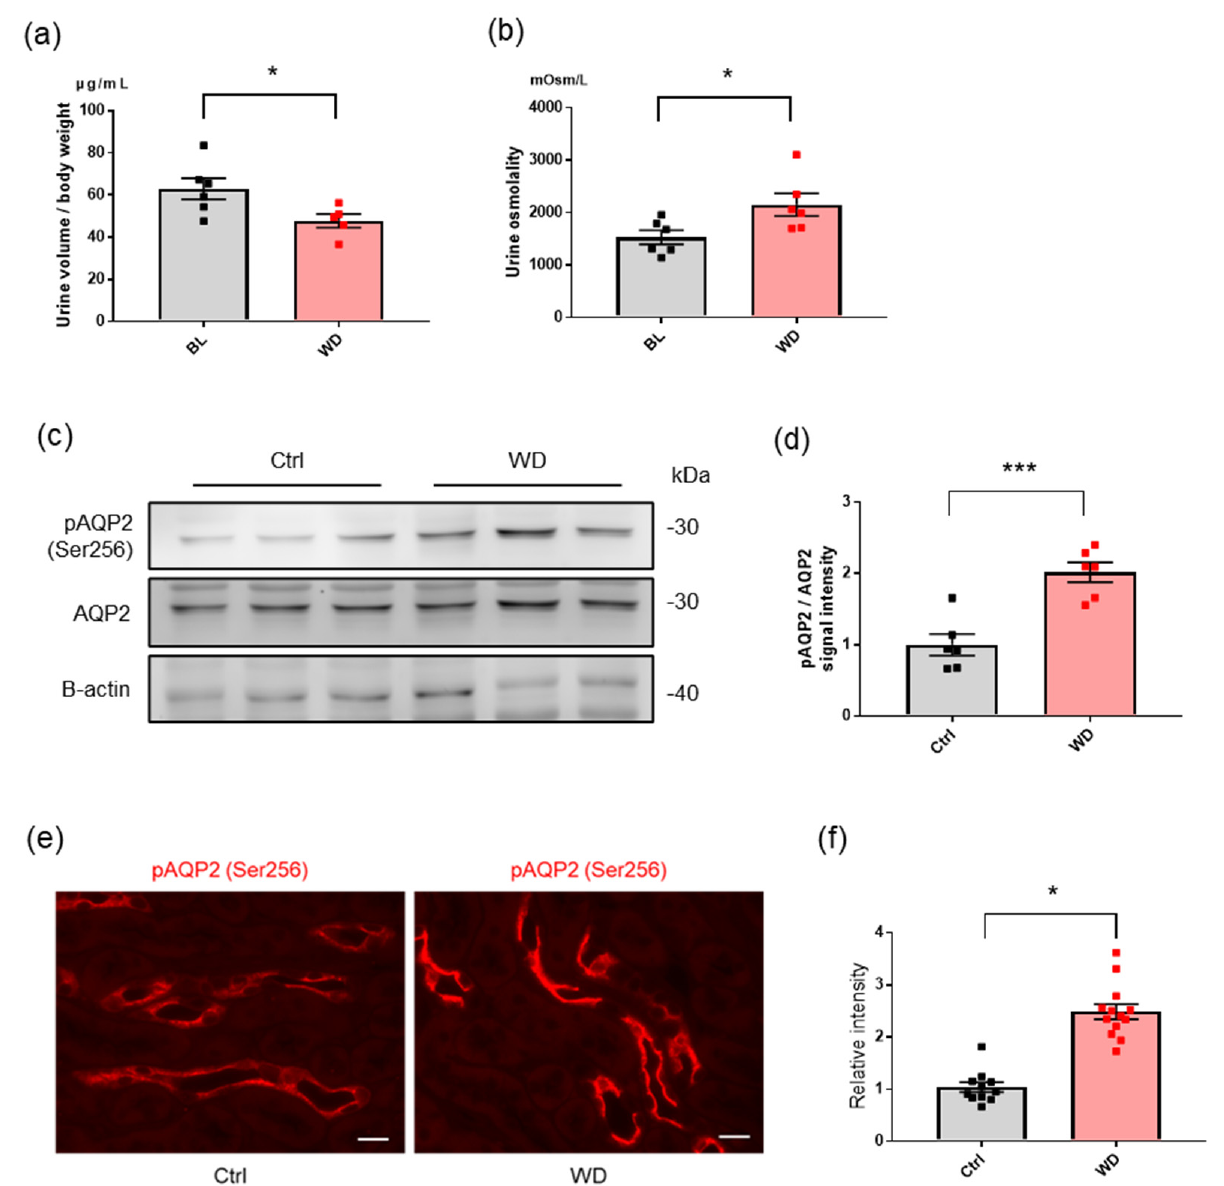
Figure 2. Activation of AQP2 by water deprivation. Changes in urinary volume ( a ) and urine osmolality ( b ) in mice at baseline and after 24 h of water deprivation. Each dot represents a mouse. * p < 0.05 (Welch’s t -test). ( c ) Western blot analysis for Ser256 − phosphorylated and total AQP2 in kidney tissue from control mice and mice under water deprivation. β − actin is also shown as a loading control. ( d ) Quantification of the signal intensities expressed as a ratio of phosphorylated AQP2 to total AQP2. N = 6. *** p < 0.001 (Unpaired t -test). ( e ) Representative immunofluorescence images for Ser256 − phosphorylated AQP2 (red) in kidney sections from control and water − deprived mice. The scale bar indicates 20 µ m. ( f ) Quantification of the ratio of phosphorylated AQP2 signal intensities to the tubular area. The analysis was based on at least three microscopic fields of tissue from each group of mice. * p < 0.05 (Unpaired t − test).